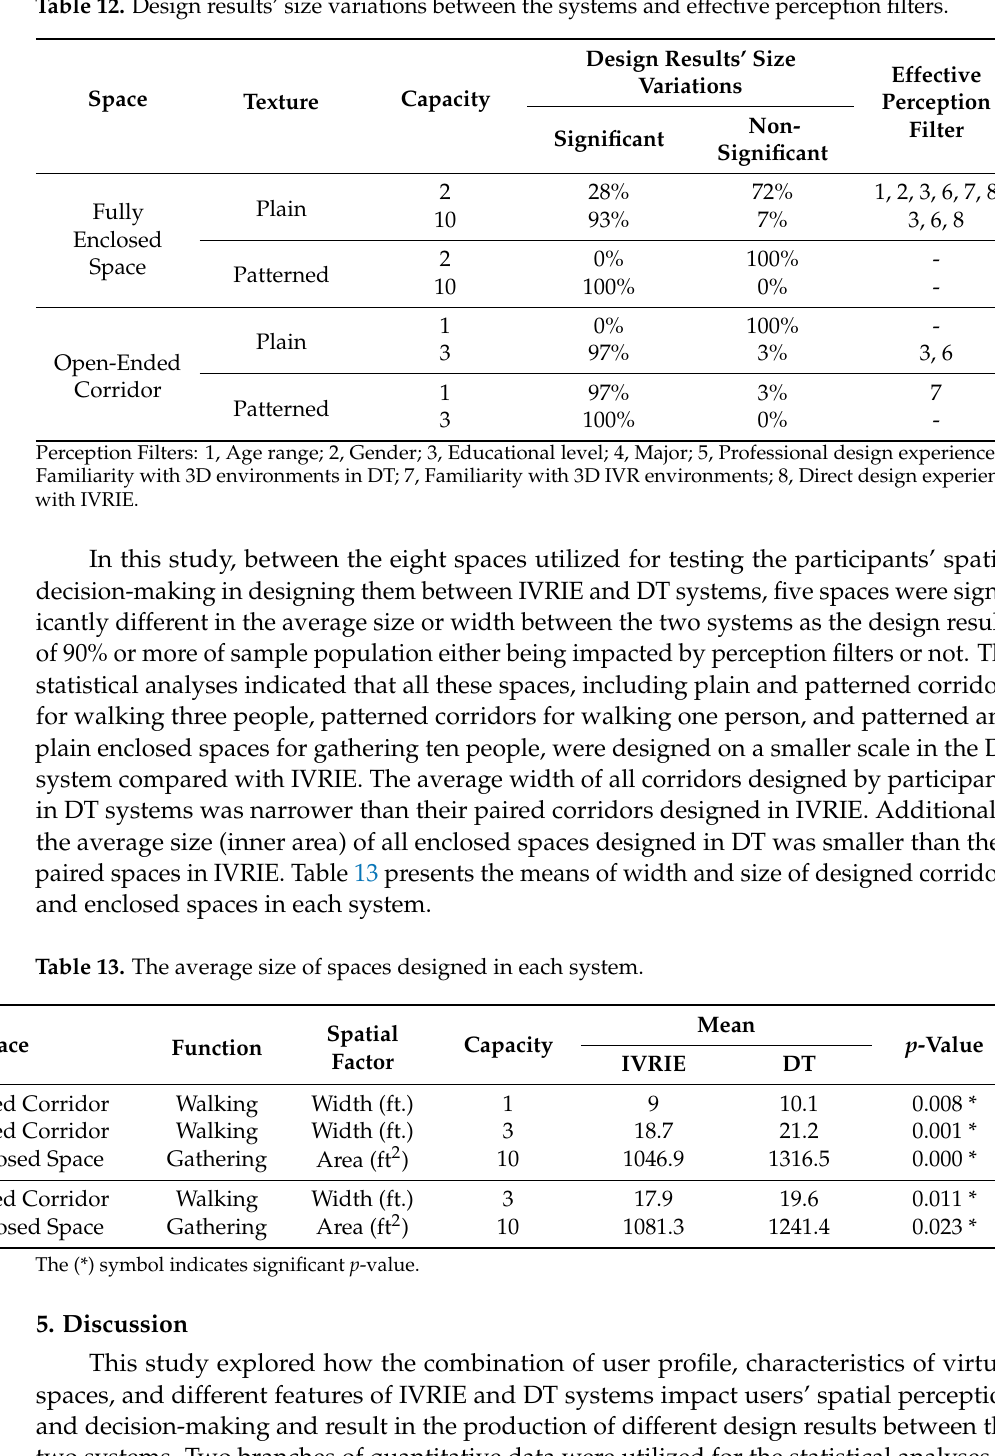
Table 12. Design results’ size variations between the systems and effective perception filters.